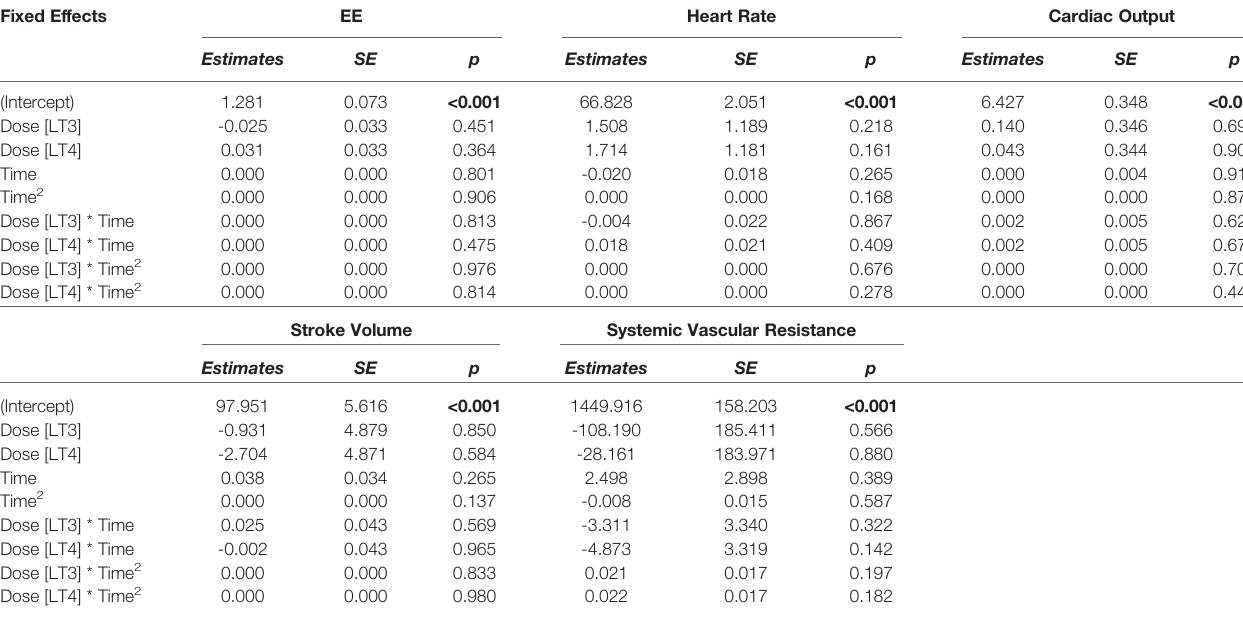
TABLE 4 | Results from linear mixed-effects models for changes in EE and hemodynamic metrics. Fixed